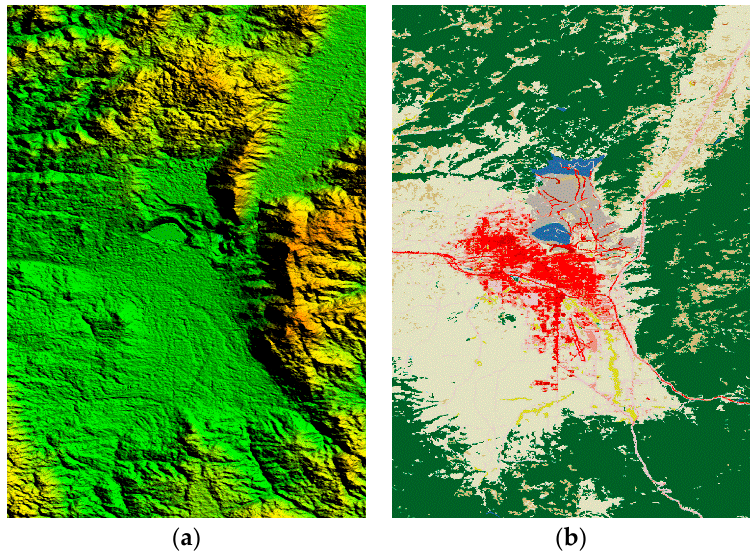
Figure 4. The original maps of the DEM data and DLCD: ( a ) The original maps of the DEM data; ( b ) The original maps of the DLCD.